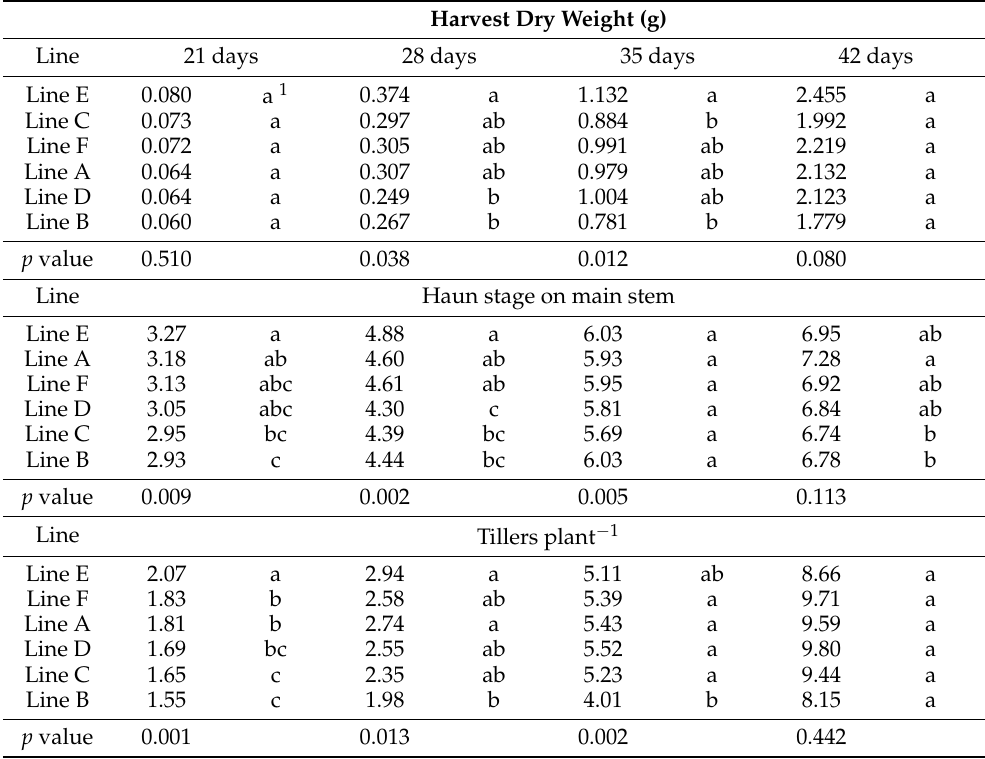
Table 3. Seedling harvest dry weight, Haun stage and tillers plant − 1 at harvest comparisons for 21, 28, 35 and 42 days after imbibition amongst lines over six growth room